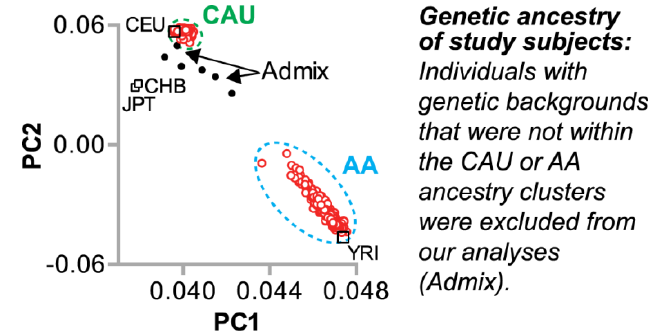
Figure 1. Principal component analysis of all genotyped Heart Healthy Lenoir (HHL) study participants. Five hundred and twelve HHL samples identified with either Caucasian American (CAU) or African American (AA) ancestry ( ○ ) or admixed samples (●). HapMap samples of known ancestral origins are identified ( (cid:3) ): CEU, Utah residents with Northern and Western European ancestry; CHB,